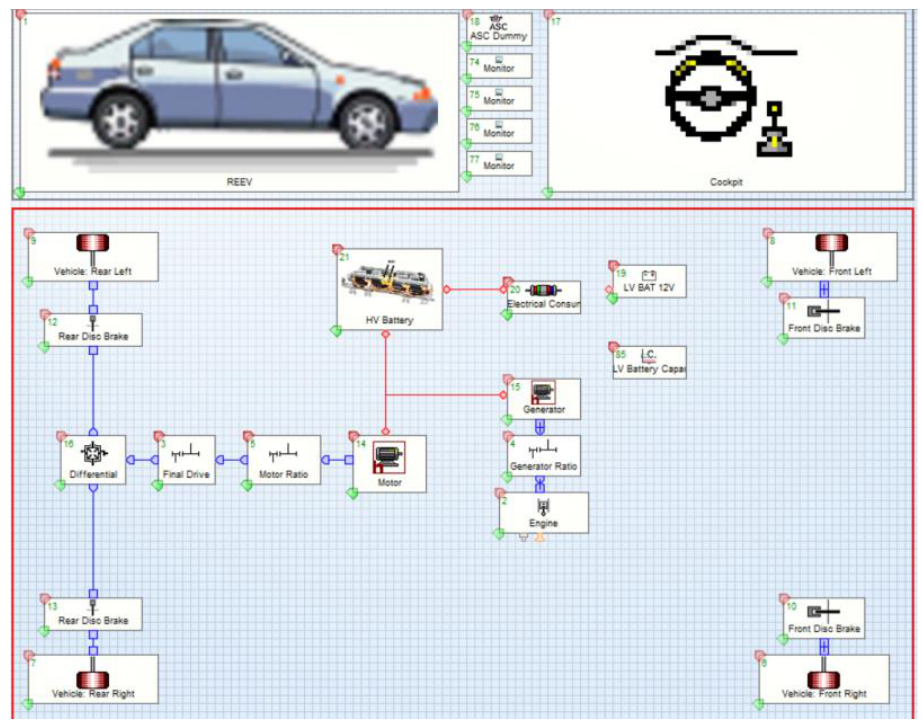
Figure 6. Vehicle model, constructed with AVL Cruise.